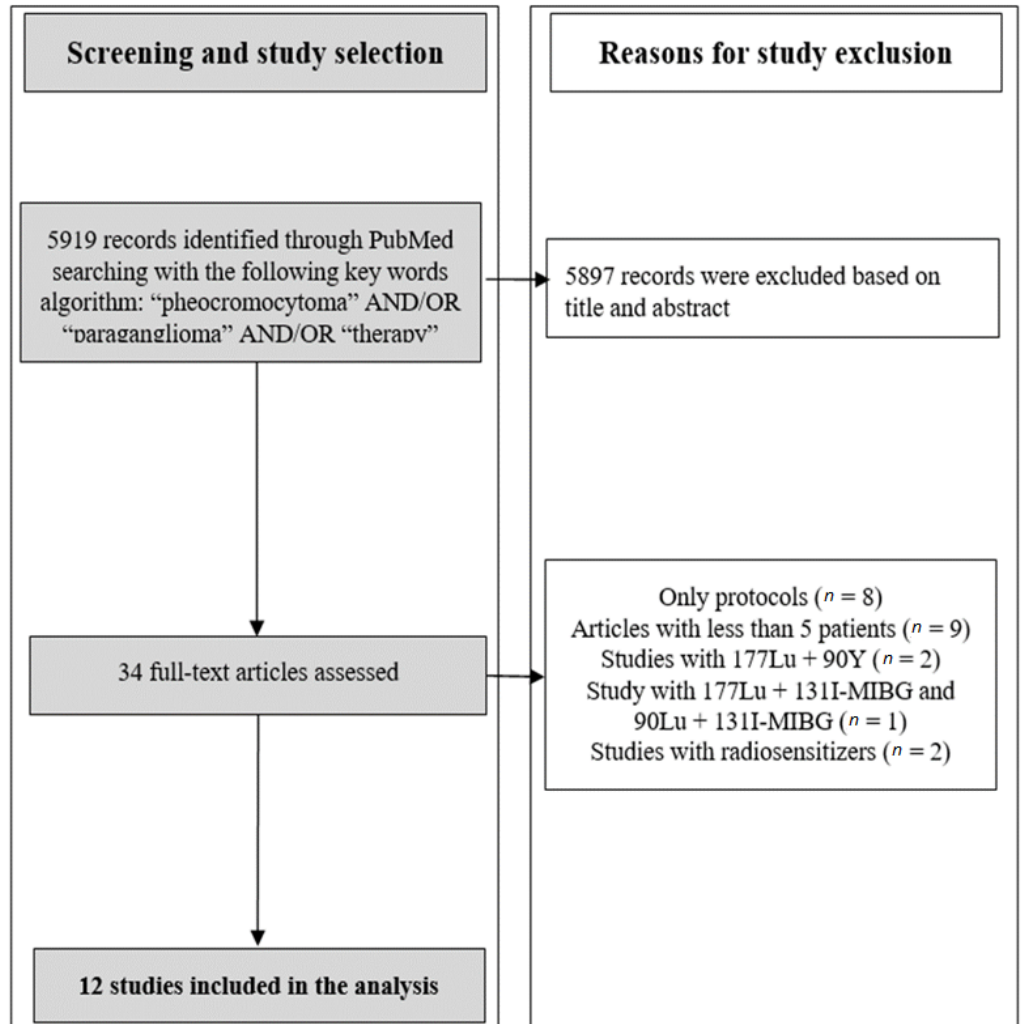
Figure 1. Selection flow-chart of studies included in the meta-analysis.